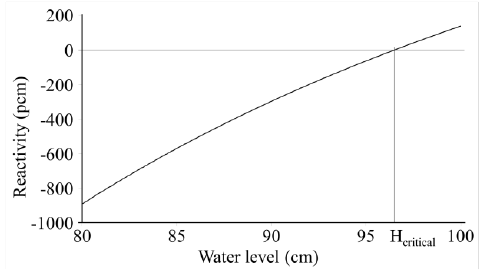
Fig. 1. Reactivity dependence on water level around criticality.